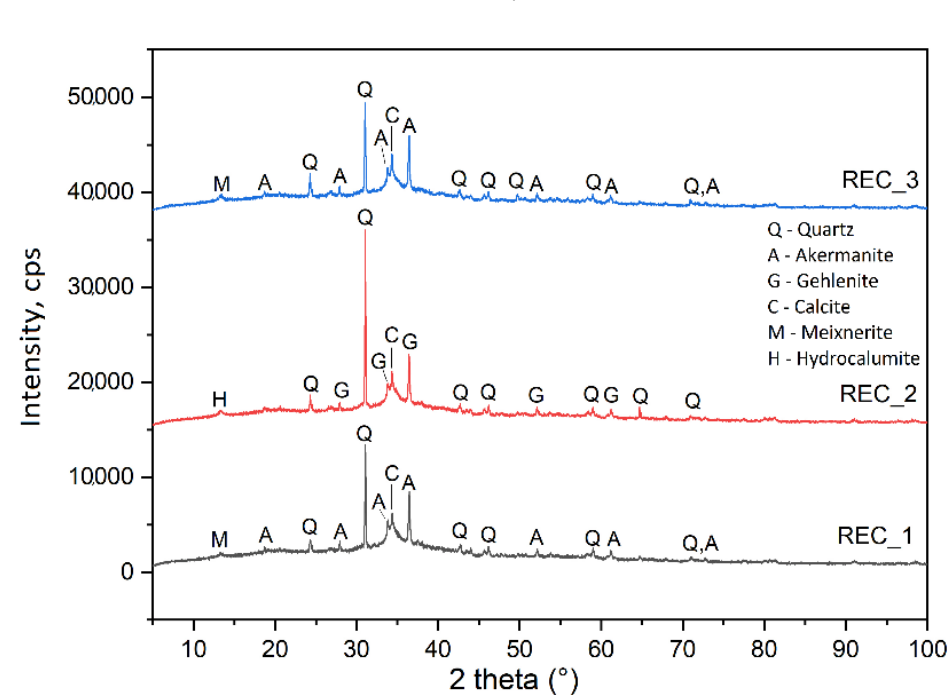
Figure 14. Mineralogical composition determined by X-ray diffraction (XRD) of prepared alkali activated pastes.